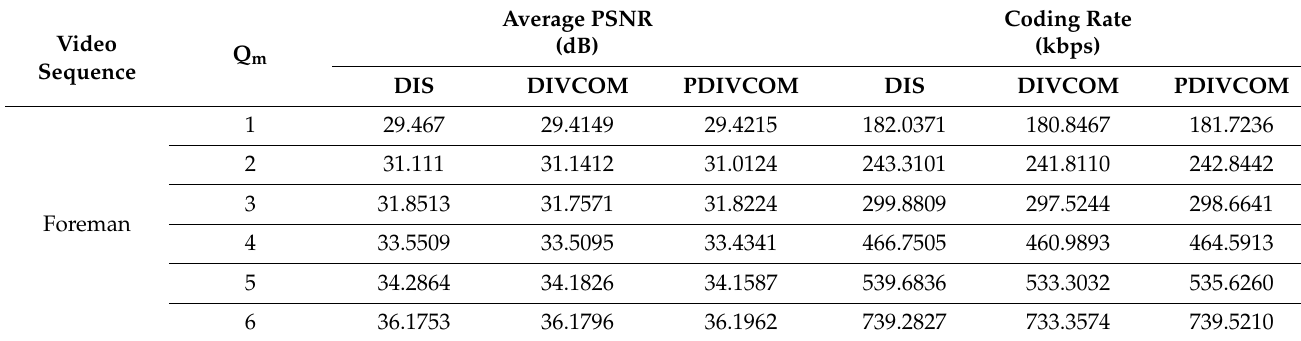
Table 6. Visual quality and rate performance evaluation of different codecs for “Foreman” video sequence at frame rate of 15 Hz.